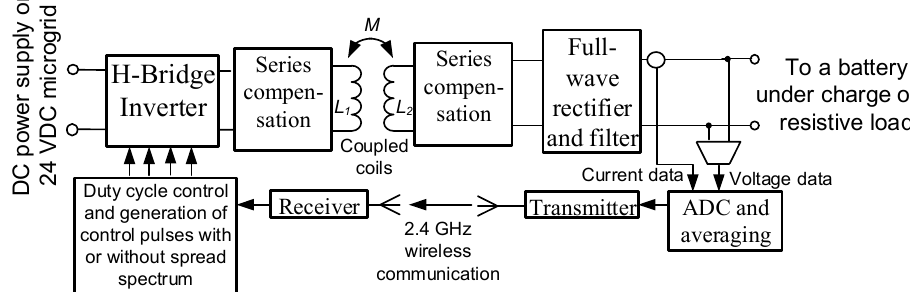
Figure 3. A block diagram of the designed prototype.